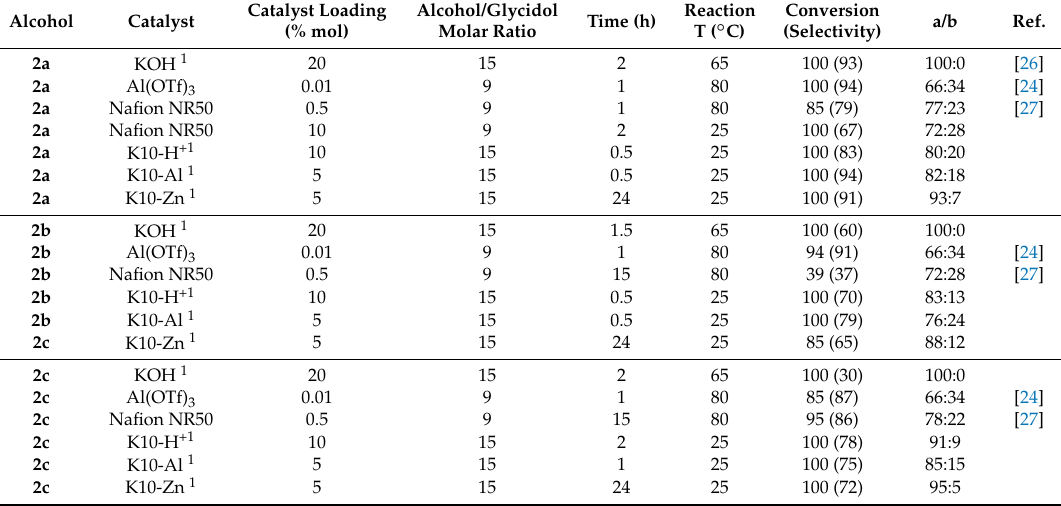
Table 3. Comparison of the synthetic methodologies for the synthesis of GMEs ( 3 – 5a and 3 – 5b ).